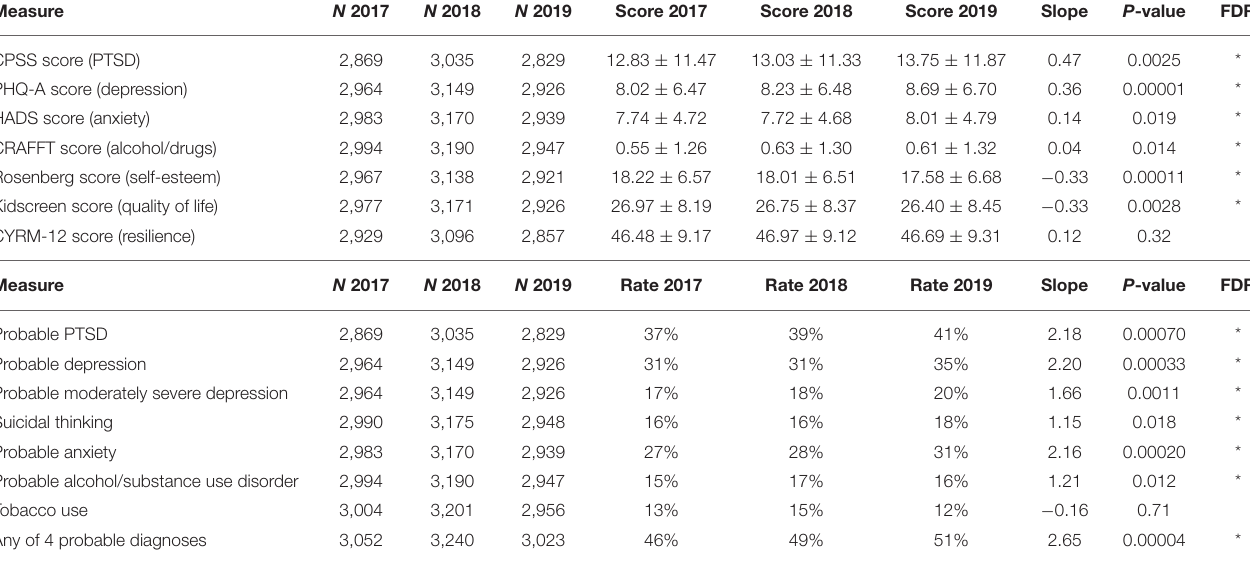
Table shows participant numbers, summary statistics, and results for analysis of effects of time. N X columns indicate number of participants from year X. Score X columns show mean ± standard deviation (not standard error) for year X. Rate X columns indicate rates of probable diagnosis for year X. Slope is the fitted slope parameter from a linear model with age and gender partialled out (see discussion of nuisance variables in the Materials and Methods). The slope parameter indicates the linear relationship between time and the dependent variable, independent of age and gender. P-values were derived from permutation testing on the slope parameters. Comparisons with an asterisk under the FDR column survived FDR multiple comparison correction. P-threshold for FDR correction was 0.025.